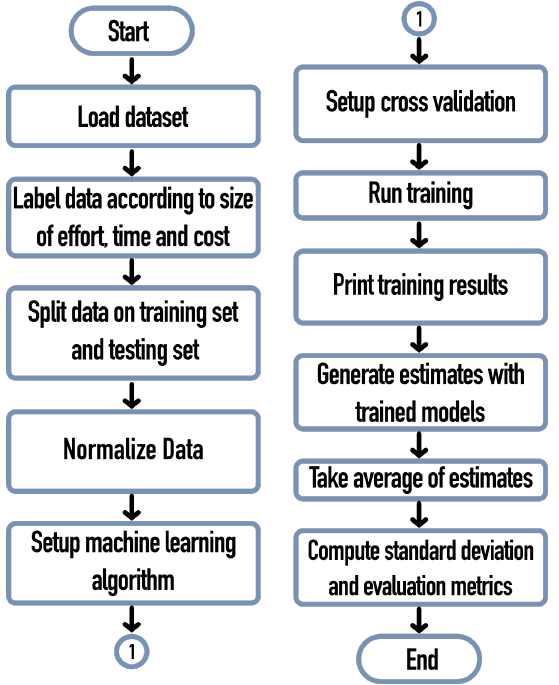
Figure 5. Flowchart of this project strategy.